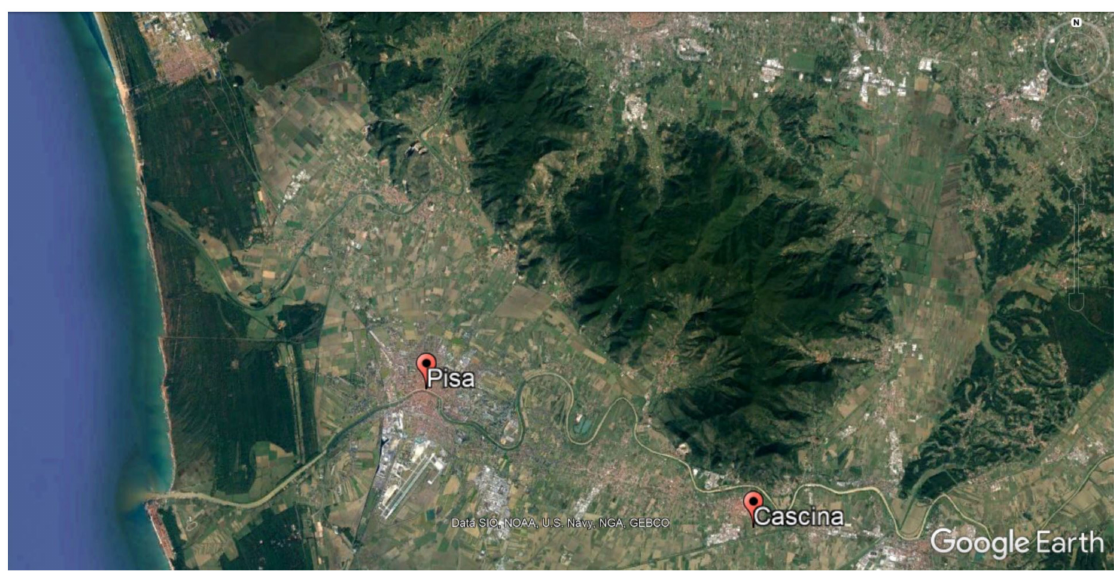
Figure 2. Map of the study area (1 cm = 2